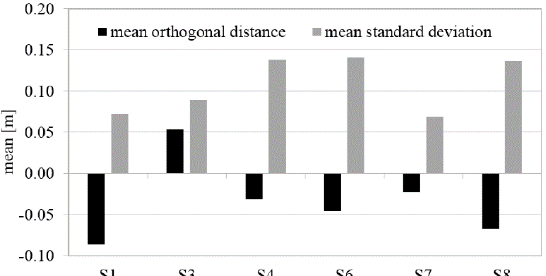
Figure 9: Statistics of signed point-to-plane distances separated by